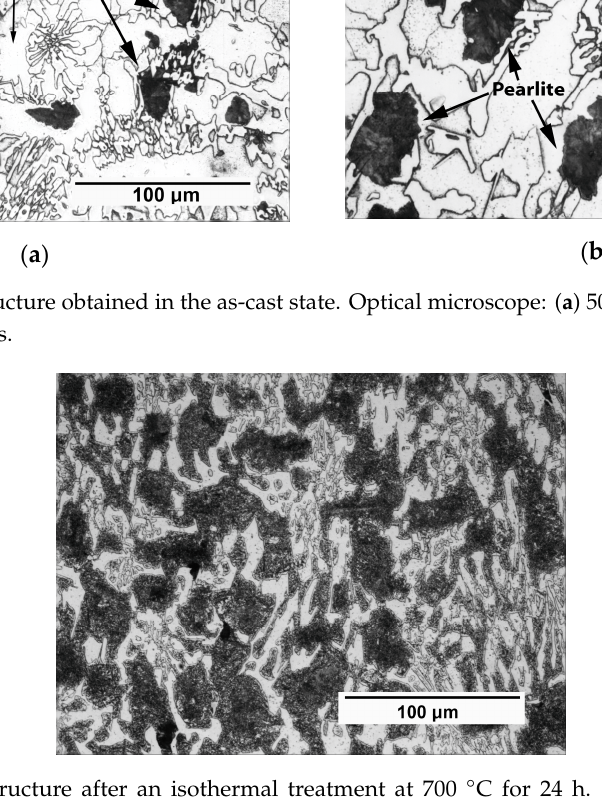
Figure 2. Microstructure after an isothermal treatment at 700 °C for 24 h. Optical microscope: 500 magnifications.